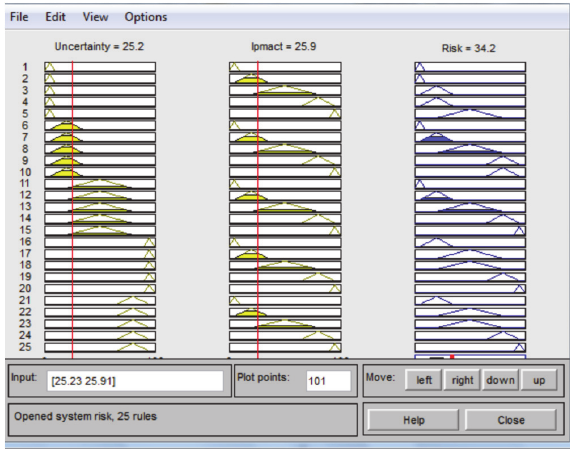
Fig. 5. Fuzzy inference system designed in order to prioritize safety risks